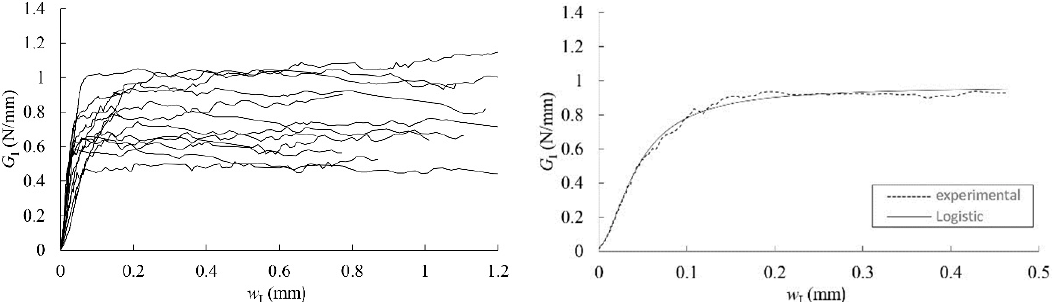
Figure 8. Characteristic G I - w I curves in RL (left); experimental G I - w I curve of “189-2-RL” specimen and least-square regression with the logistic function (right).